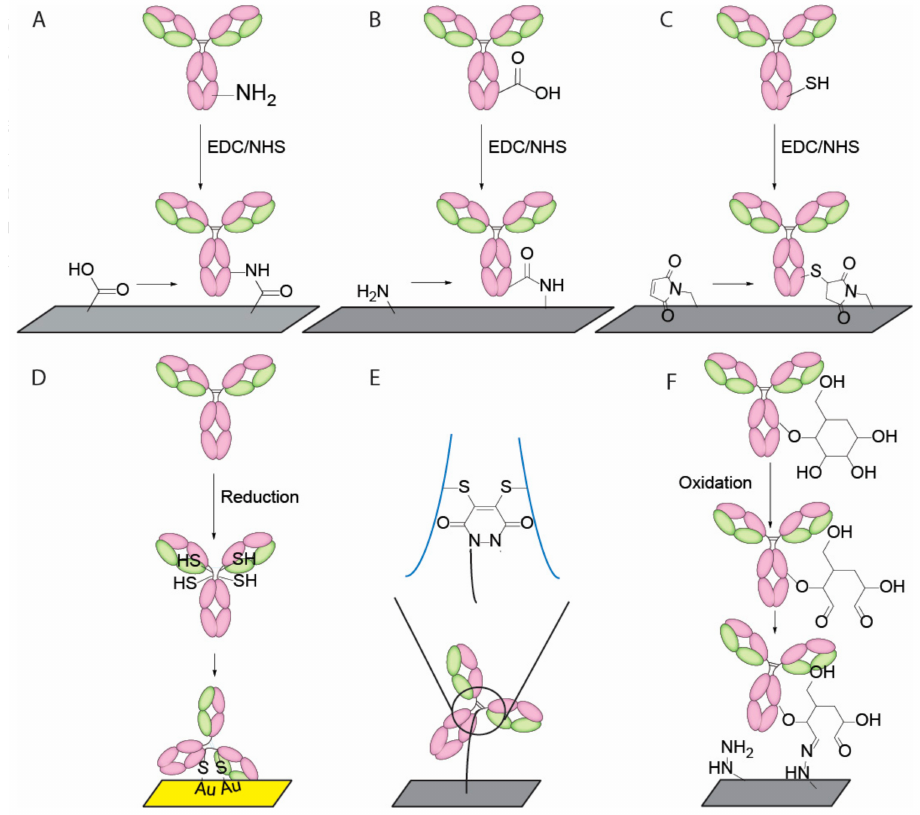
Figure 3. Ab immobilization scheme. ( A ) EDC/NHS coupling of Ab surface amine to carboxyl and ( B ) carboxyl groups to amine groups; ( C ) Sulfhydryl-reactive chemical group coupling to Ab surface thiol groups; ( D ) Reduction of antibody disulfides to reactive thiols for gold substrates binding; ( E ) Reduction of antibody disulfides for site specific pyridazinedone coupling; and ( F ) Oxidation of sugar chains for reactive aldehyde